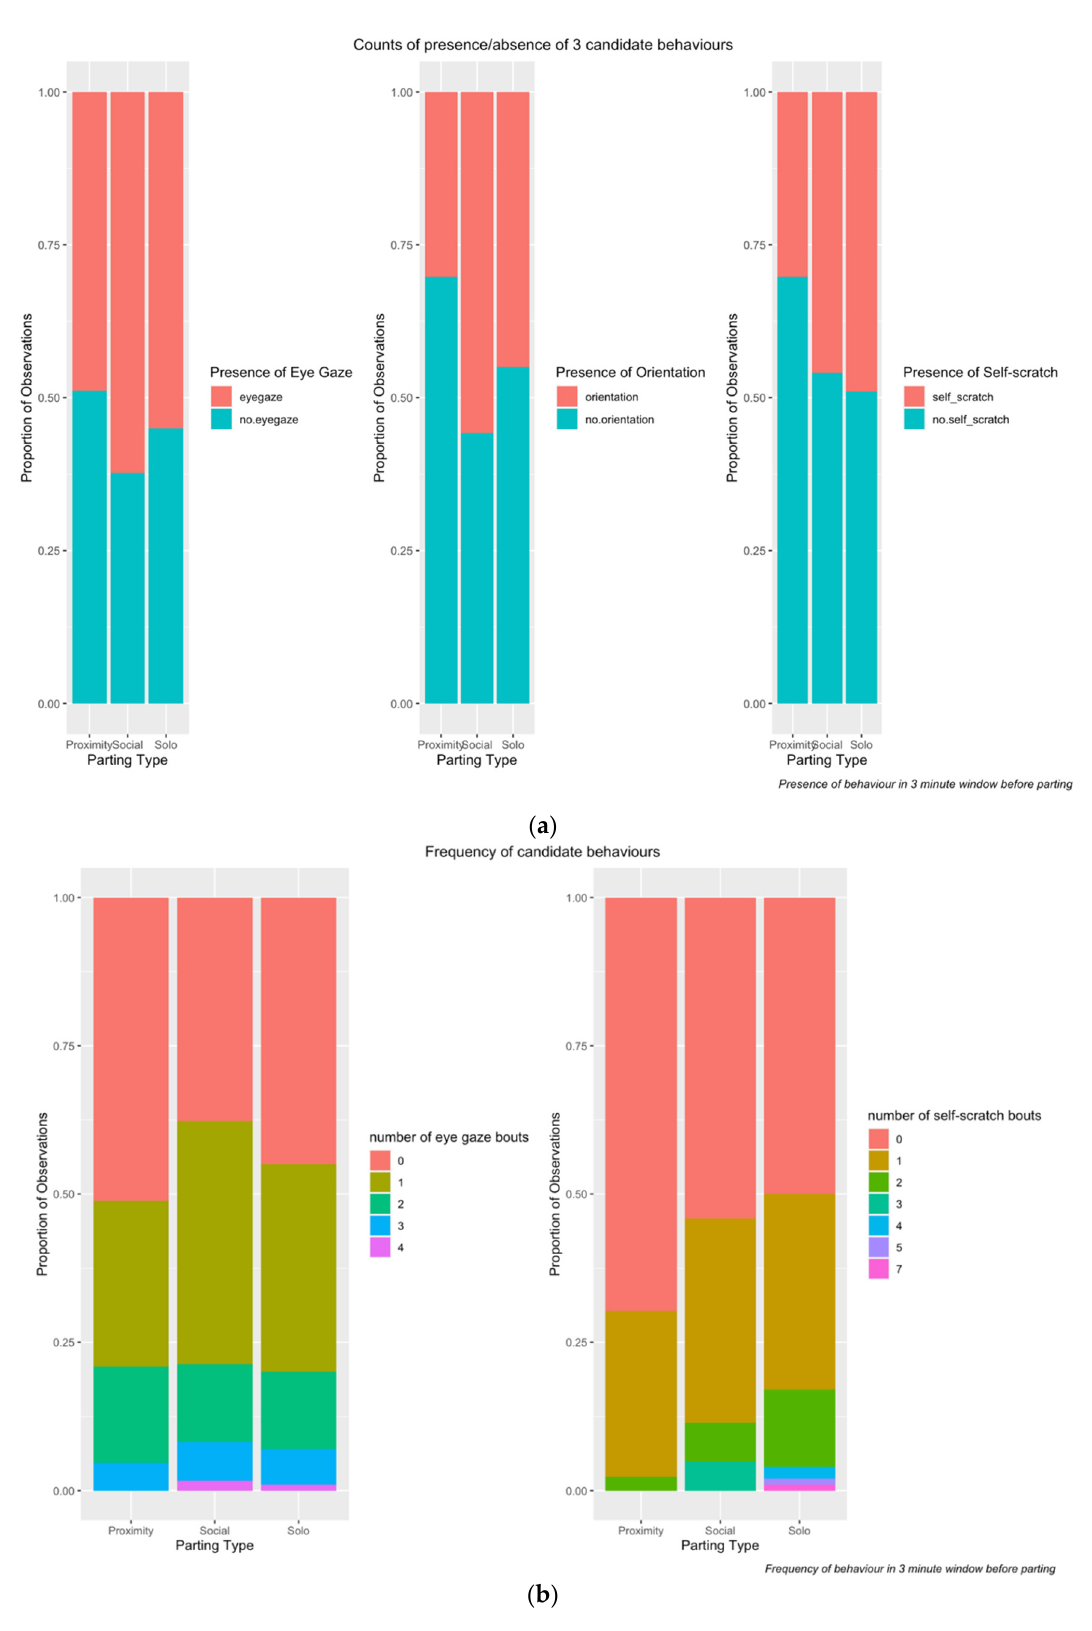
Figure 4. ( a ): Proportion of observations where candidate behaviours were present / absent. ( b ): Proportion of observations with each count of candidate behaviours .